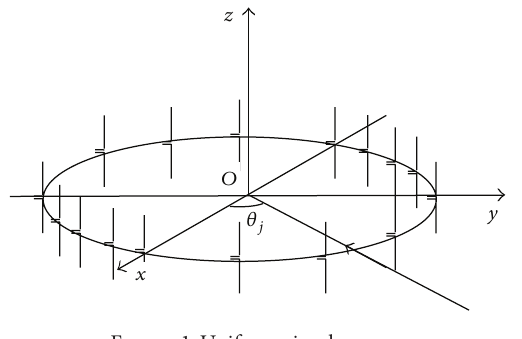
Figure 1: Uniform circular